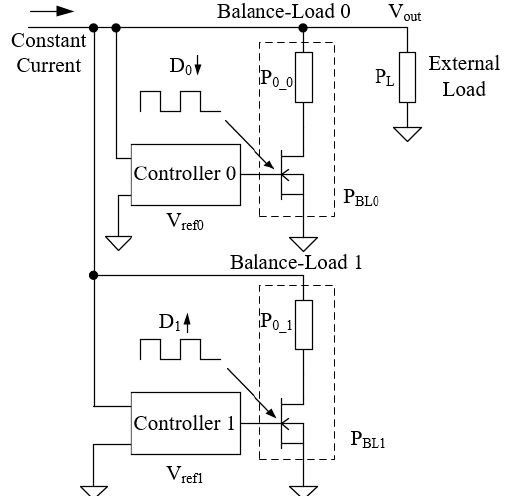
Figure 9. The equivalent circuit of the DC/DC output side before opening K B leads to a positive feedback of the power distribution, through which the PPMS can be achieved.